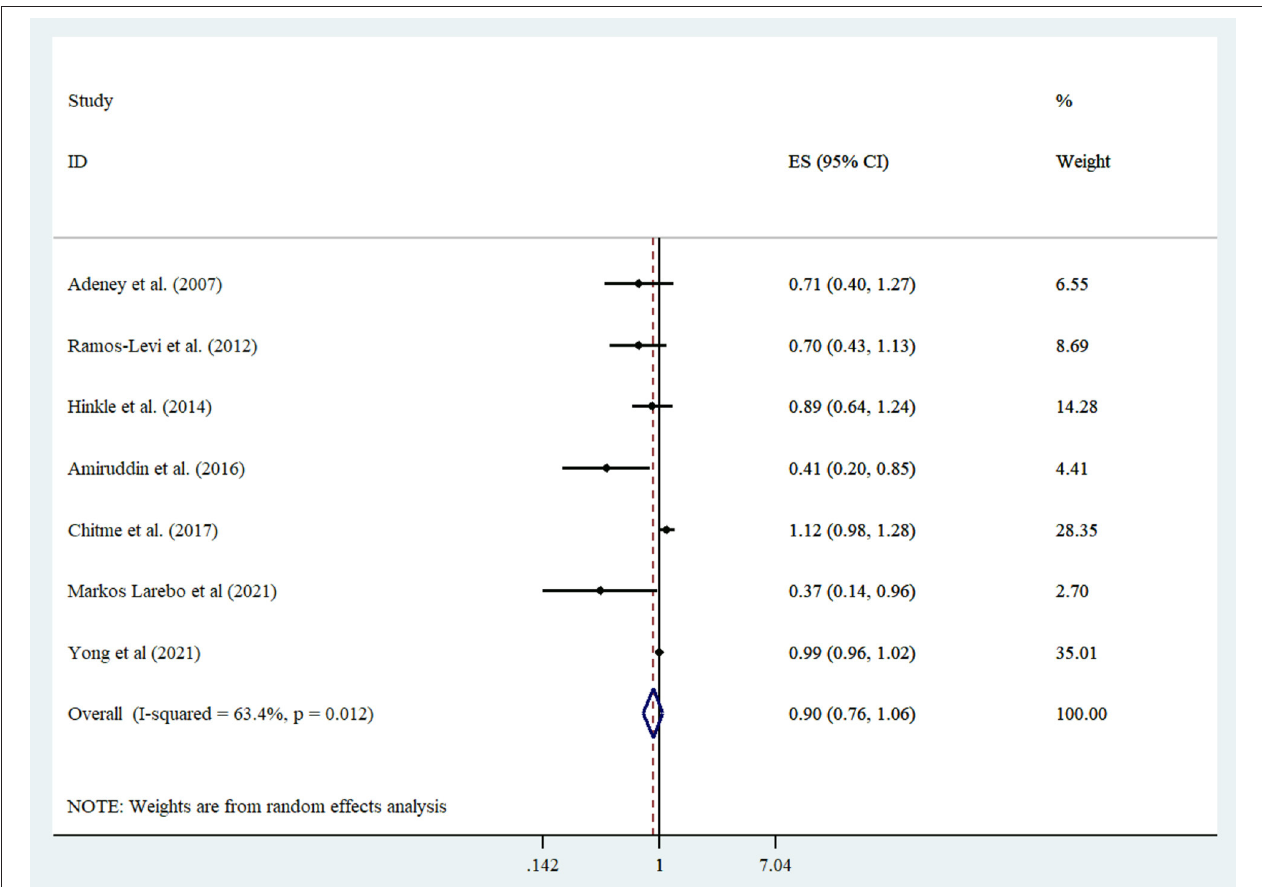
FIGURE 2 | Forest plot derived from random effects meta-analysis of studies investigating the association between high vs. low intake of consumption of coffee and gestational diabetes mellitus. CI, confidence interval; ES, effect size.